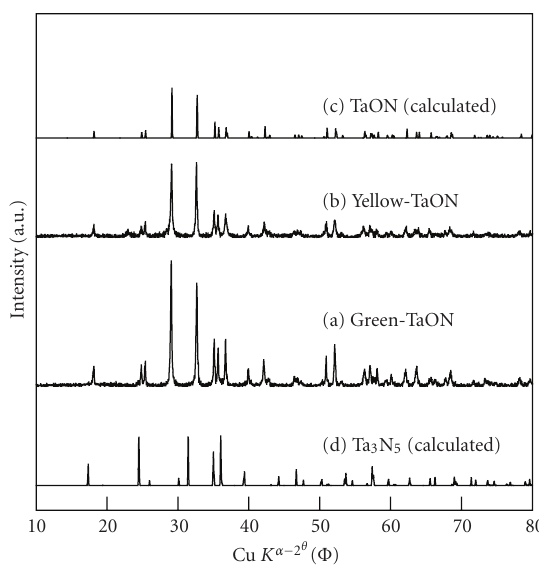
Figure 1: XRD patterns in (a) green TaON synthesized via liquid- NH 3 process, (b) yellow TaON synthesized via liquid-NH 3 process, (c) TaON (calculated), and (d) Ta 3 N 5